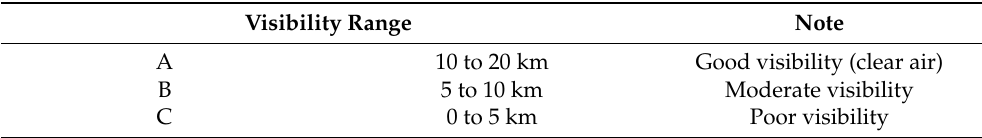
Table 3. Definitions of visibility